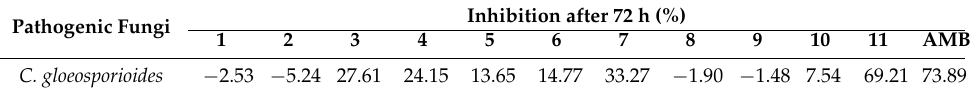
Table 2. Inhibitory activities of compounds 1 – 11 (100 mg/mL) against C. gloeosporioides.